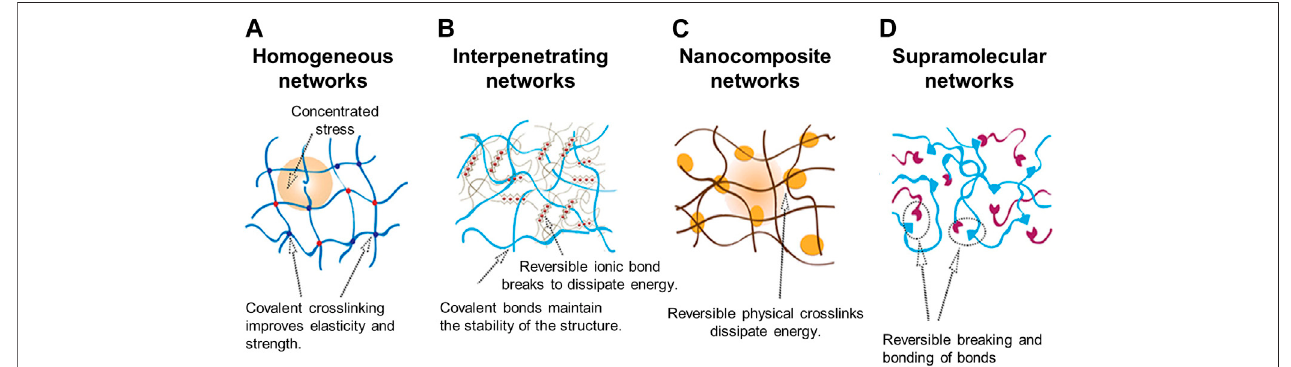
FIGURE2| Schematicillustration offourinterconnectingnetworksinmulticomponent hydrogelbioinks (A) Homogeneousnetworks (B) Interpenetratingnetworks (C) Nanocomposite networks (D) Supramolecular networks. Reproduced with permission from (Li et al.,